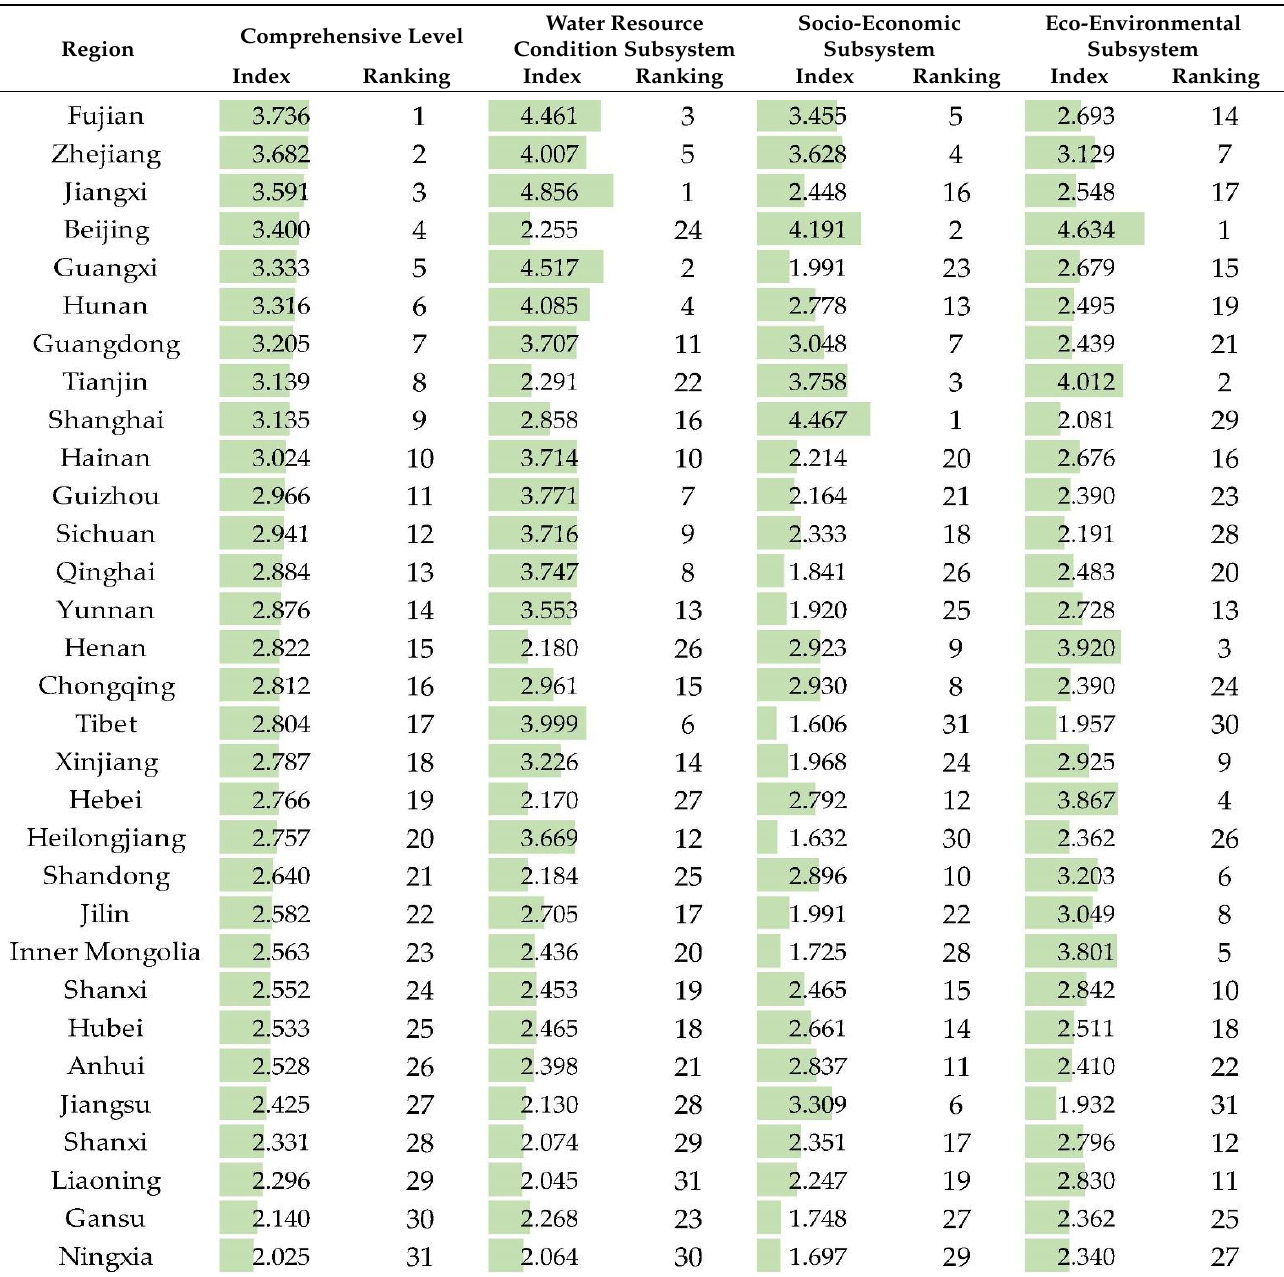
Table 5. Comprehensive evaluation indices and rankings of sustainability of water resources use and evaluation indices and rankings of subsystems by province and city in China.